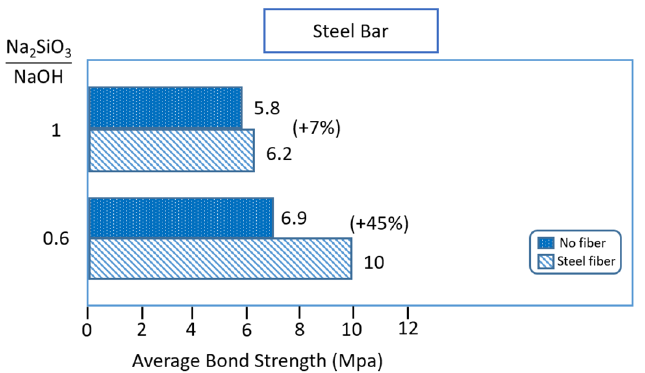
Figure 13. Effects of Na 2 SiO 3 to NaOH ratio and steel fiber inclusion on the bond strength of geopolymer concrete with embedded steel bars (Reproduced with permission from reference [55]). Table 3. Summary of the mechanical resistance of reinforced concrete related to the binder